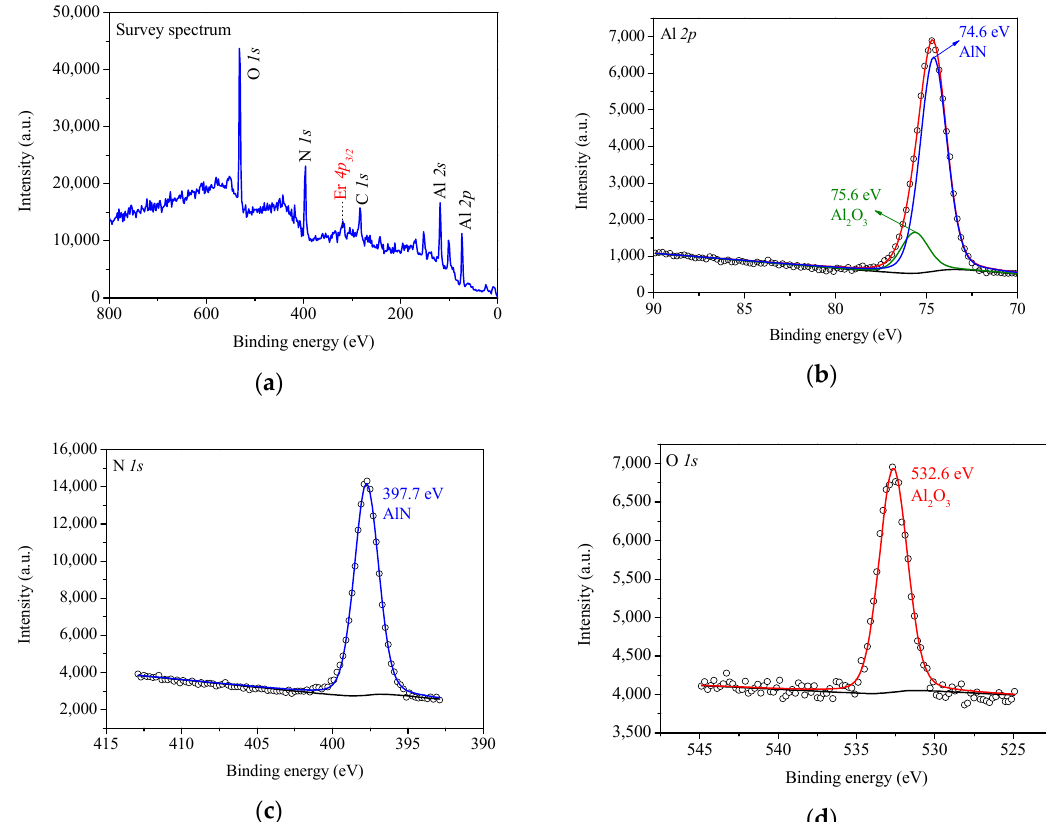
Figure 2. Photoelectron spectra ( a ) survey, ( b ) Al 2p , ( c ) N 1s and ( d ) O 1s for a typical AlN:Er sample deposited at 400 °C after 10 min of Ar + milling.